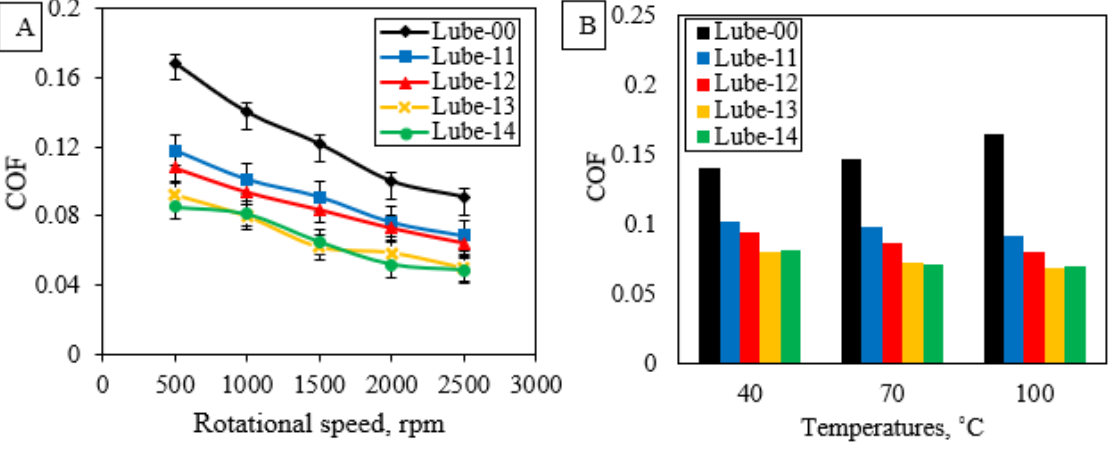
Figure 3. The friction coefficient of hybrid nano lubricant samples with various loading contents of 0.5 to 2 wt% Al 2 O 3 NPs and 0.5 wt% MWCNTs ( A ) at different speeds and ( B ) at different temperatures.